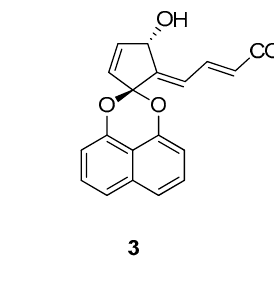
Figure 1. Dioxynaphthalenoids 1–3 from Sparticola junci . Sparticatechol A ( 1 ) was obtained as an optically active reddish-brown syrup. The molecular formula C 23 H 22 O 9 , indicating 13 degrees of unsaturation, was established based on the protonated molecular ion peak at m/z 443.1330 [M + H] + of its positive-ion HRESIMS. This is consistent with the number of proton and carbon peaks detected in its 1 H and 13 C NMR spectroscopic data (Table 1). Detailed examination of the 1 H, 13 C, and HSQC-DEPT NMR spectroscopic data revealed the presence of a carboxylic acid carbon, a ketal carbon, seven non-protonated aromatic carbons (four oxygenated and three non- oxygenated), nine aromatic methines, three sp 3 methylene and two oxygenated sp 3 me- thine carbon. Table 1. NMR Spectroscopic Data of 1 and 2 in MeOH- d 4 . Position